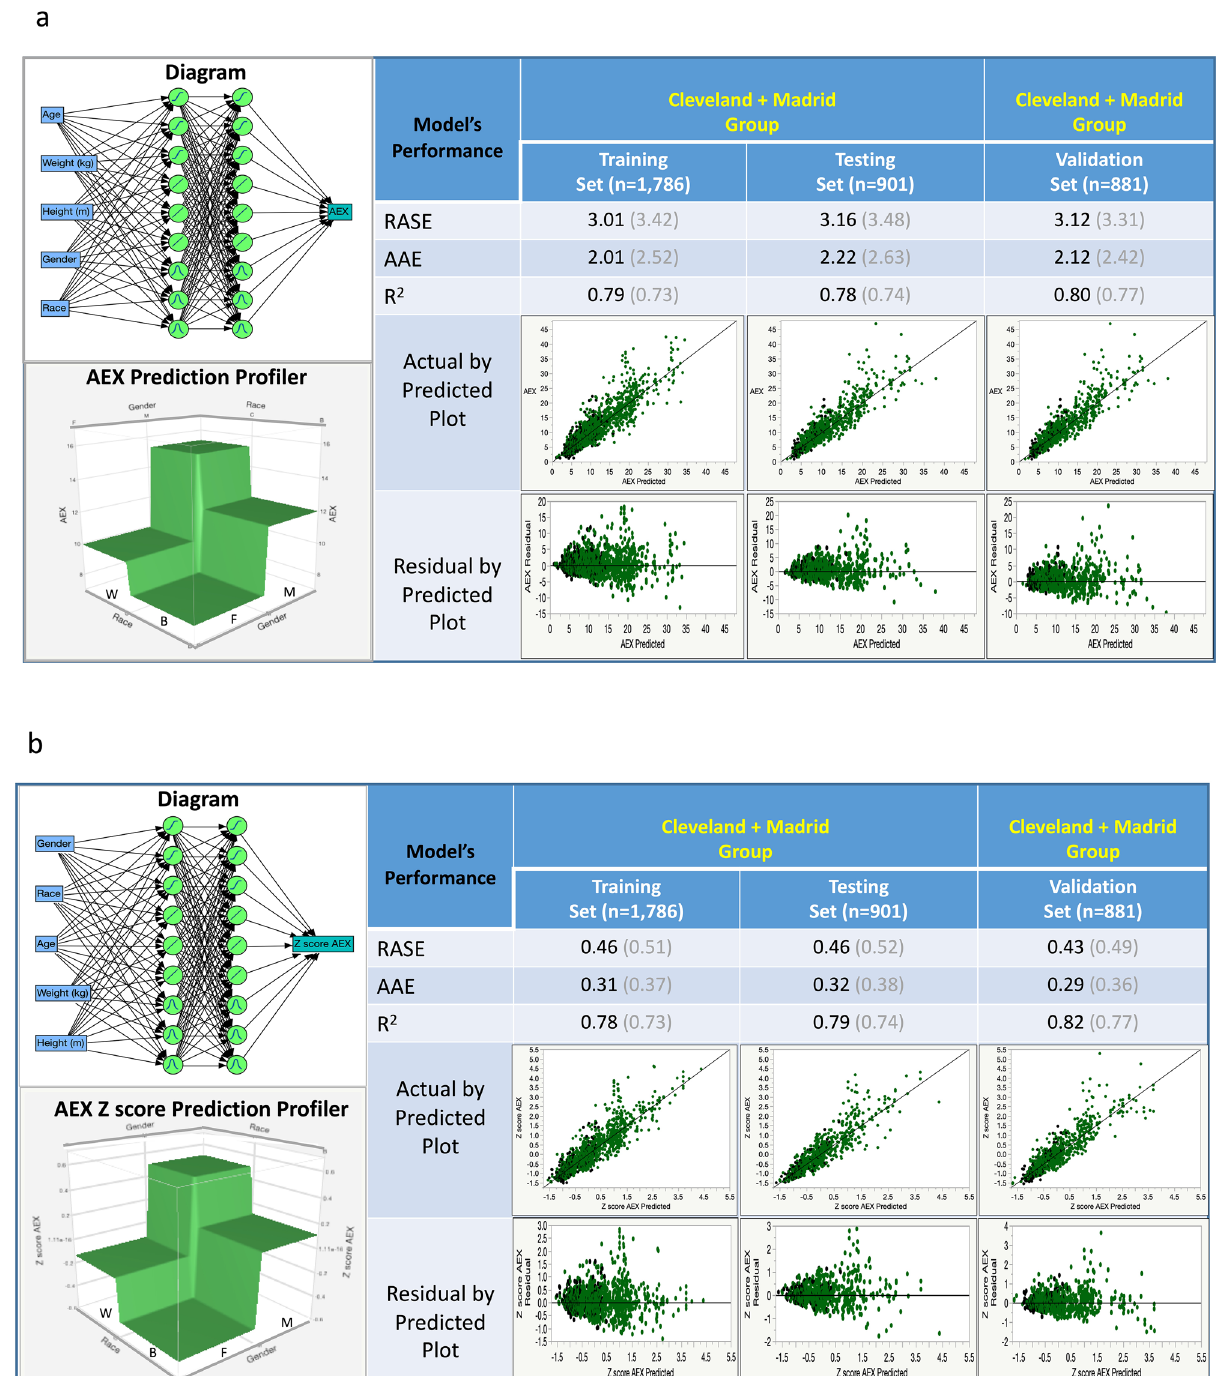
Figure 6. Machine learning (artificial neural network) models predicting AEX ( a ) and AEX z scores ( b ) using as inputs gender, race, age (years), weight (kg) and height (m), with Ongoing Validation. Left upper corner shows the model diagram, while left lower corner illustrates the prediction profiler by gender and race. The main table reveals the high performance of the model predicting both AEX and AEX z scores in all subject groups (derivation and validation sets), without a ‘cohort effect’—a drop in the R 2 from internal to external validation sets. For comparison, the R 2 , RASE and AAE of the regression model are shown in grey (in brackets). Color codes—green: Cleveland group; black/grey: Madrid group. dark colors (green and black): males; light colors (green and grey): females. AEX area under expiratory flow-volume curve, B black, W white, F female, M male, AAE average of absolute error, R 2 R squared statistic, RASE square root of the mean squared prediction error, calculated as the square root of the sum of squares error divided by